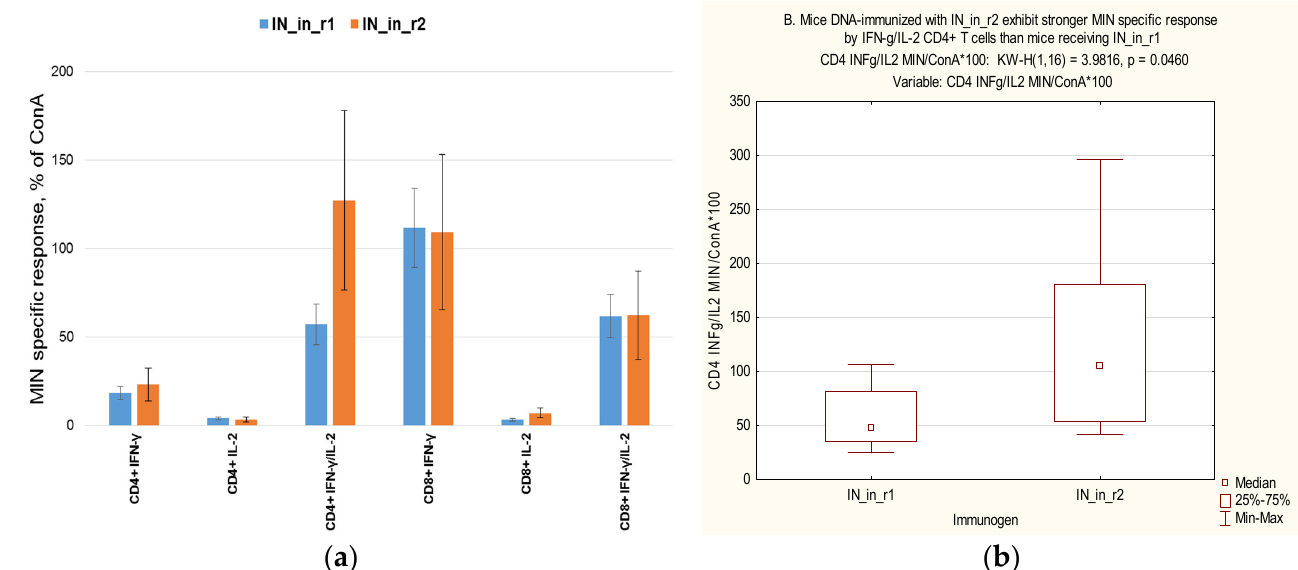
Figure 12. DNA immunogens encoding inactivated HIV-1 integrases with two patterns of resistance to raltegravir (IN_in_r1, IN_in_r2) differ in the ability to induce integrase-specific IFN- γ /IL-2 response by CD4+ T cells. IFN- γ , IL-2, IFN- γ /IL-2 response of CD4+ and CD8+ T cells of mice DNA-immunized with IN_in_r1 or IN_in_r2 (Series I, II; Table 1) were presented as % of response of respective cell populations to ConA ( a ); statistically significant difference in proportion of MIN-specific IFN- γ /IL-2 secreting CD4+ T cells ( b ). Data represent average values for mice DNA-immunized with IN_in_r1 (Series I/group 3, n = 4; Series II/group 1, n = 6) and IN_in_r2 (Series I/group 4, n = 4; Series II/group 2, n = 6) ±SD.